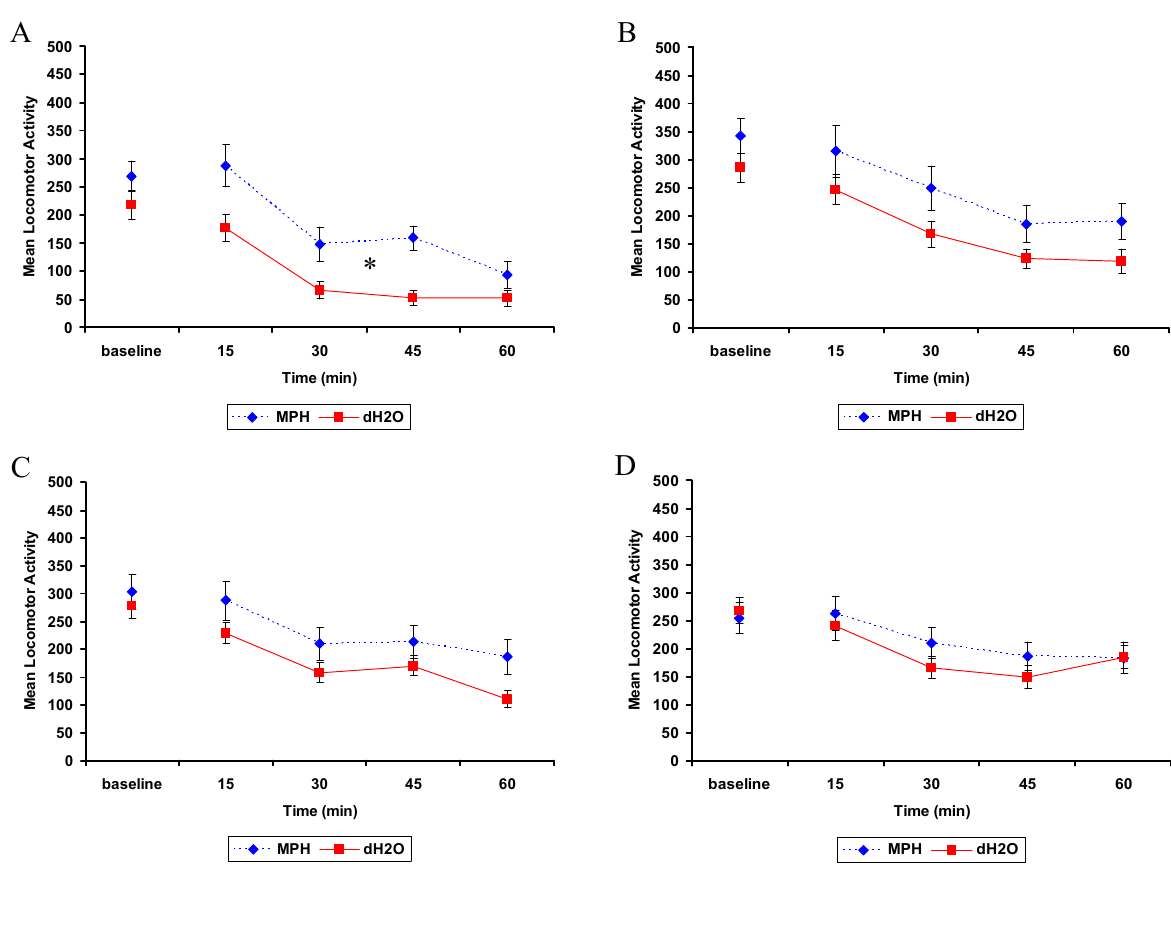
Figure 2. WKY rats: Mean (±SEM) locomotor activity at the beginning of each week of oral treatment with 2 mg/kg methylphenidate (MPH; n = 12) or distilled water (dH measured for 15 min intervals prior to (baseline) and for 1 h following treatment. * Significant difference between treatment, p < 0.05, in week 1 ( A ) with no significant effect in week 2 ( B ); week 3 ( C ); or week 4 ( D